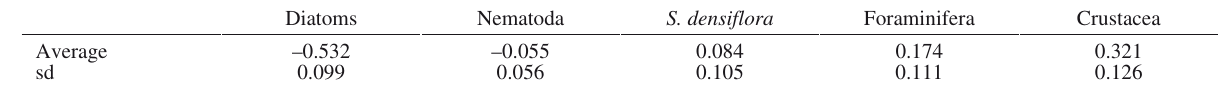
Table 2. – Neohelice granulata . Electivity indices for each food item present in the sediment after deposit feeding. Negative values indicate avoidance or inaccessibility, values close to zero, random feeding and positive values,